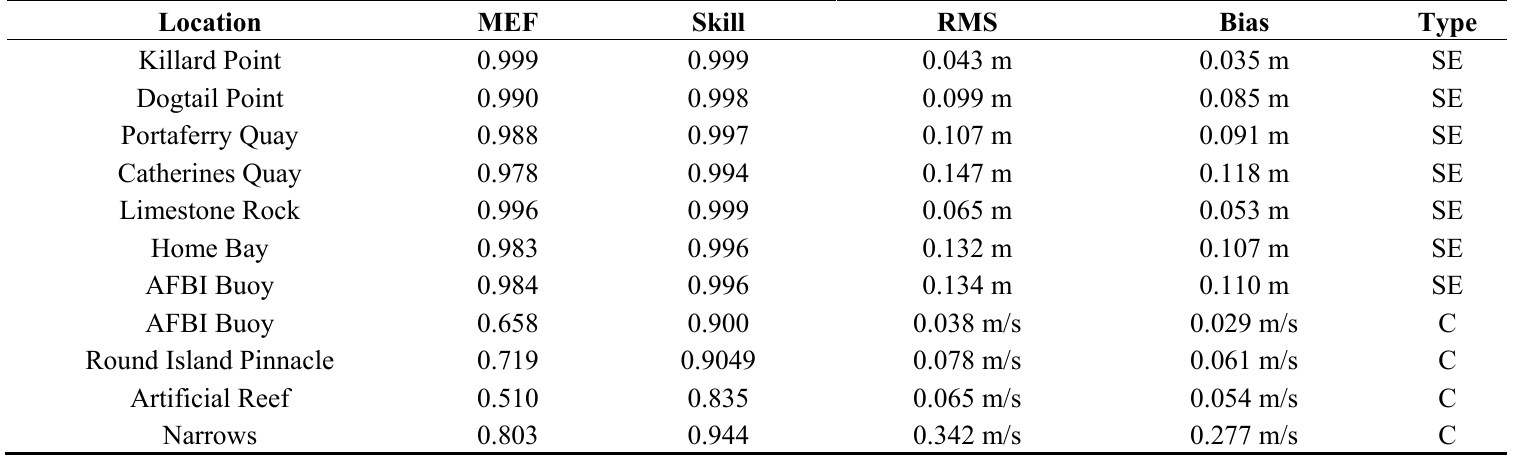
Table 3. Modelling efficiency (MEF), skill, root mean square (RMS) and bias for all the validation stations for surface elevation (SE) or current speed (C).